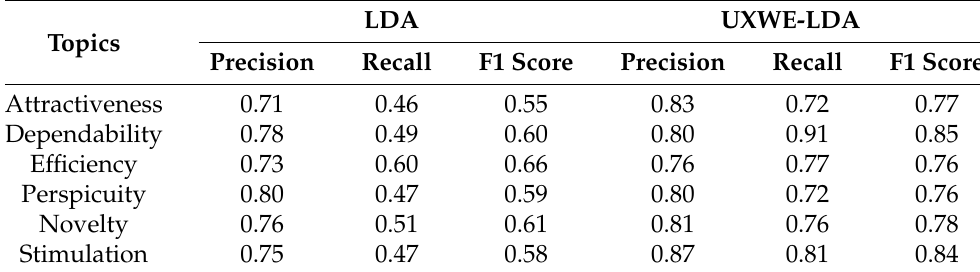
Table 4. Topic-wise performance measures.